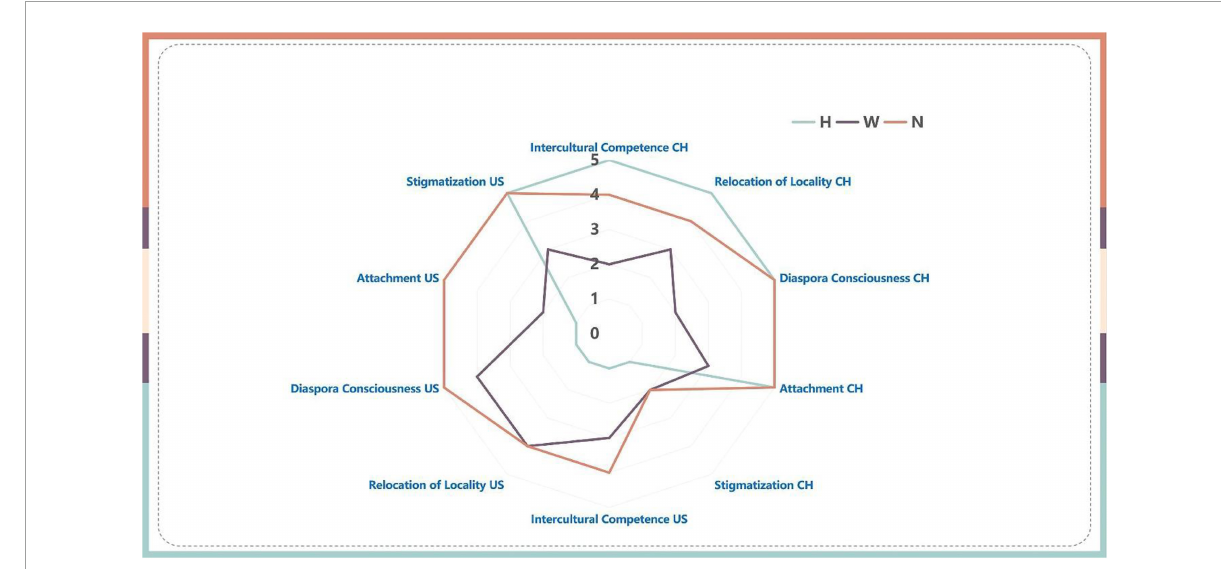
FIGURE2 Three identity clusters before COVID-19.